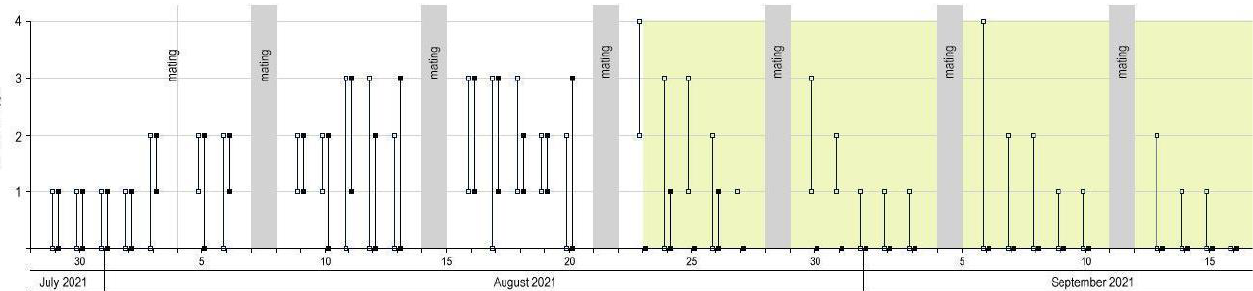
Figure 6. Acorn selection and daily egg output range (min – max) of C. glandium females tested during Experiment 4. White background — pre-hardening period: empty squares — acorn one, filled squares — acorn two; green background — post-hardening period: empty squares — pierced hard acorns, filled squares — unpierced hard acorns.